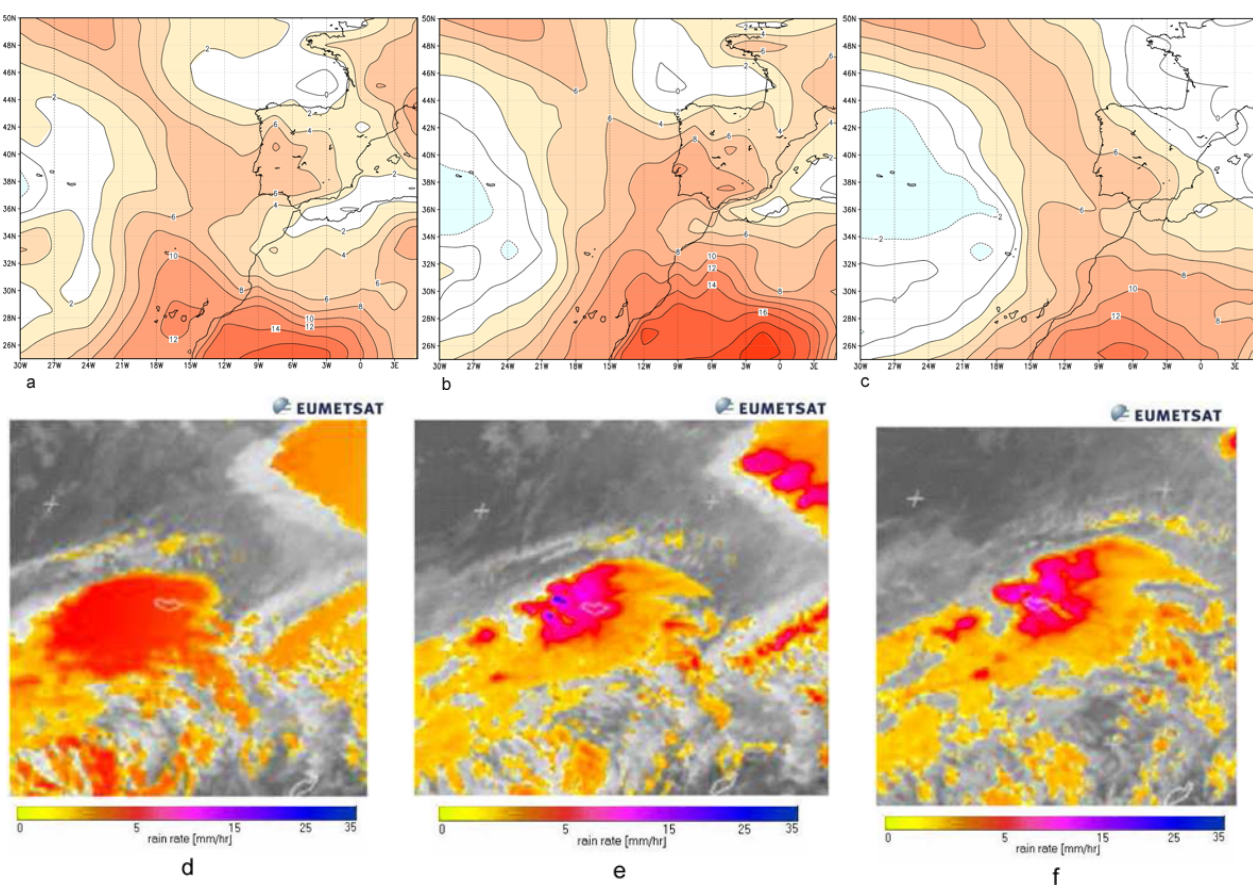
Fig. 7. Thermodynamic instability and mesoscale precipitation systems over the Madeira Atlantic sector: (a–c) Lifted index distribution over the Madeira Atlantic sector at 00:00, 06:00 and 12:00UTC (units in ◦ C, source: ERA-Interim reanalysis, ECWMF); (d–f) Multi-Sensor Precipitation Estimate (MPE) product images at 09:45, 11:15 and 11:45UTC (units inmmh − 1 , source EUMETSAT). The colours scale of the MPE images was modified in order to enhance the visibility of the island